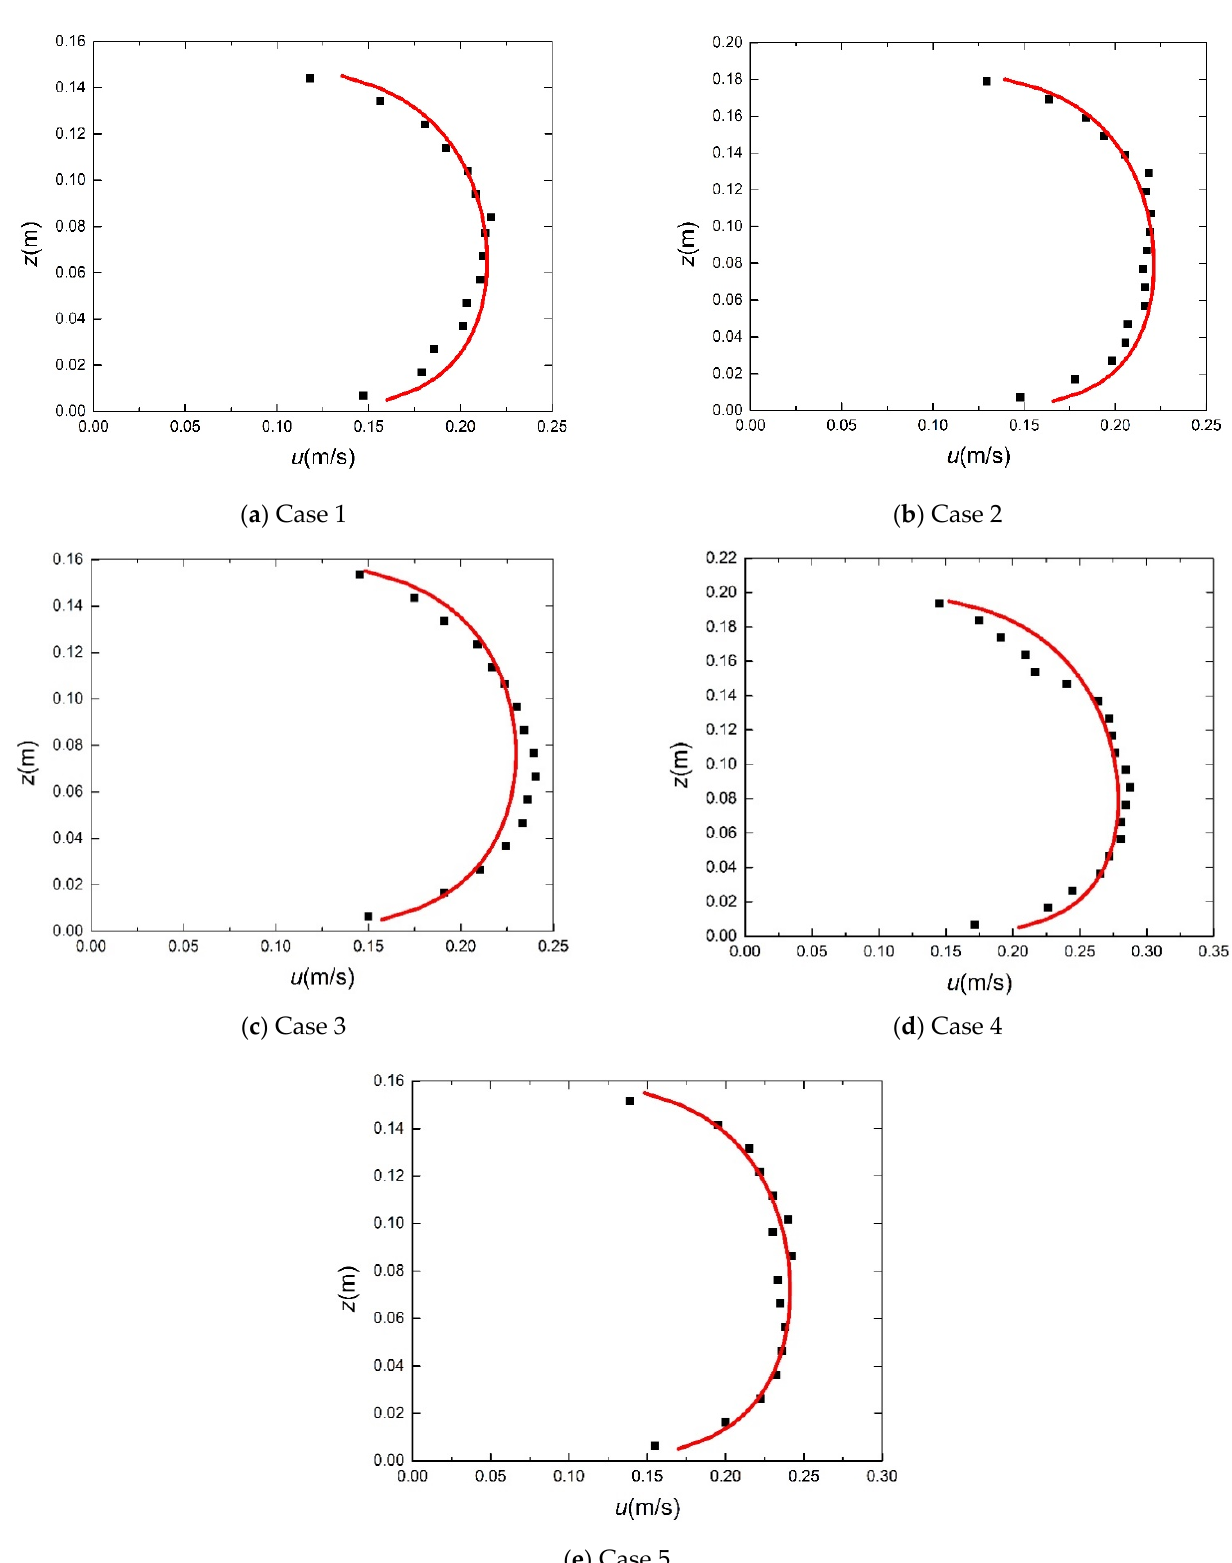
Figure 4. Comparison of the measured and analytical velocities. Black squares denote the measured data and red lines denote the analytical ones.